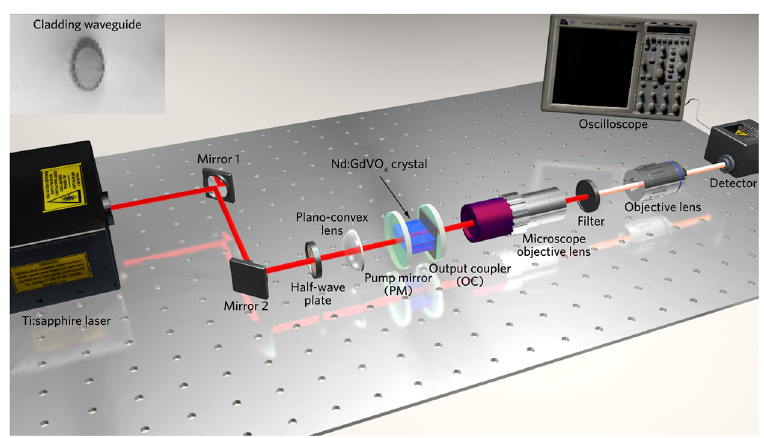
Figure 5: Schematic diagram of the typical end- facecouplingfacilityforpulsedlaserdelivery.The inset is waveguide structure (upper-left).